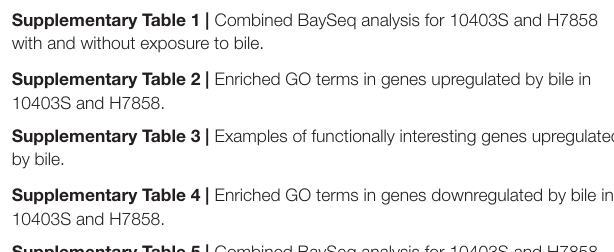
Supplementary Figure 1 | Bile exposure effect on strains 10403S and H7858.